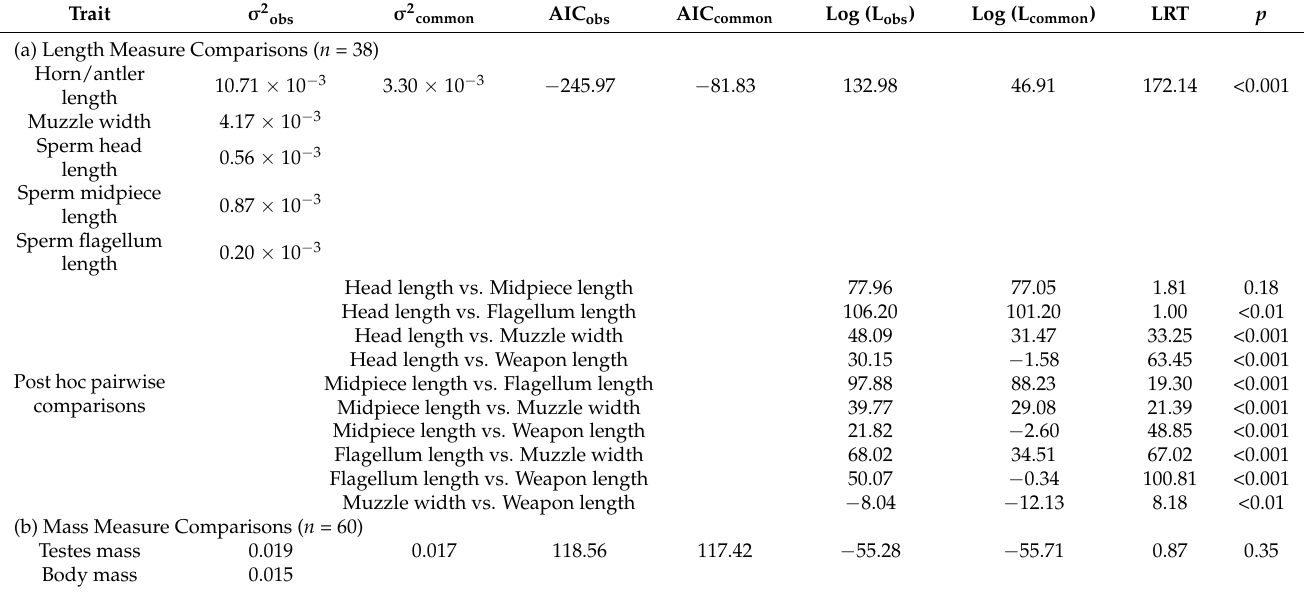
Table 1. Comparisons of evolutionary rates of (a) length measures and (b) mass measures in ungulates. The model (a) compares length measures (i.e., horn/antler length, muzzle width and sperm head, midpiece and flagellum length), while model (b) compares mass measures (testes and body mass). Note that the two models assess different numbers of ungulate species. The observed ( σ 2 obs ) and common evolutionary rate ( σ 2 common ) are shown for each trait. Additionally, presented are the AIC values for the observed (AIC obs ) and common (AIC common ) model, log-likelihood values for the observed (Log(L obs )) and common models (Log(L common )), and the log-likelihood ratio tests (LRT) and associated p-values for comparisons between observed and constrained rate models. Log-likelihood values, LRTs, and p-values are further displayed for Post hoc pairwise